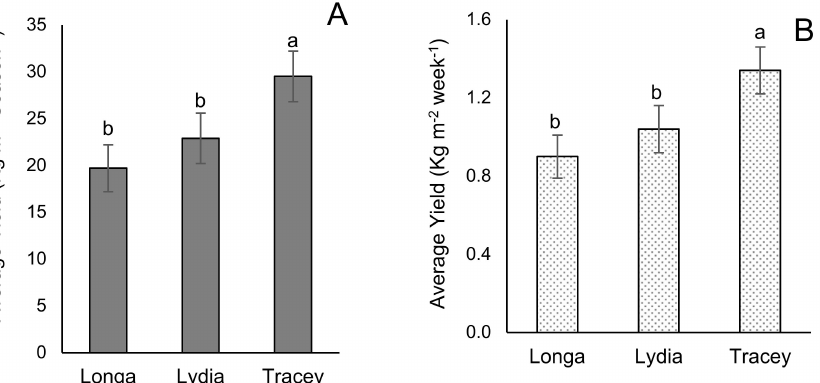
Figure 5. Eggplant fruit yield in the high − tech greenhouse. ( A ) Average fruit yield in kg per square meter over the whole growth season. ( B ) Average weekly fruit yield in kg per square meter. The whole growing season lasted for 6 months. Data are mean ± SE (n = 10). Different lowercase letters indicate statistical significance at p < 0.05.